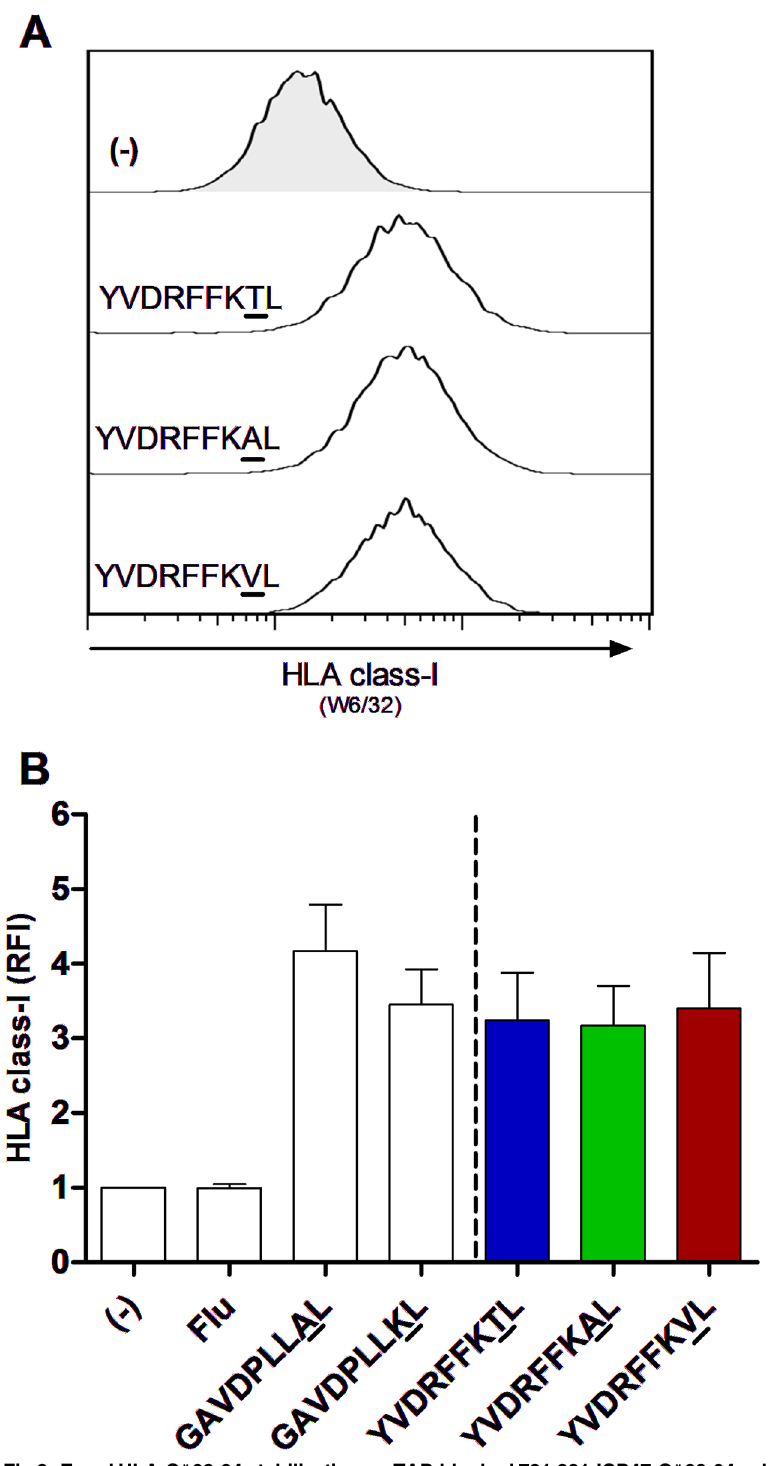
Fig 2. Equal HLA-C * 03:04 stabilization on TAP-blocked 721.221-ICP47-C * 03:04 cell line with HIV-1 p24 Gag T Gag303 wild-type and variant peptides. (A) Representative histograms of HLA-C * 03:04 stabilization with T Gag303 wild-type and T Gag303 A and T Gag303 V variant peptides compared to addition of no peptide ( − ). HLA-C * 03:04 surface levels were determined by flow cytometry using an anti-pan — HLA class I antibody (clone W6/32). Peptides were added at a saturating concentration of 100 μ M. (B) Quantification